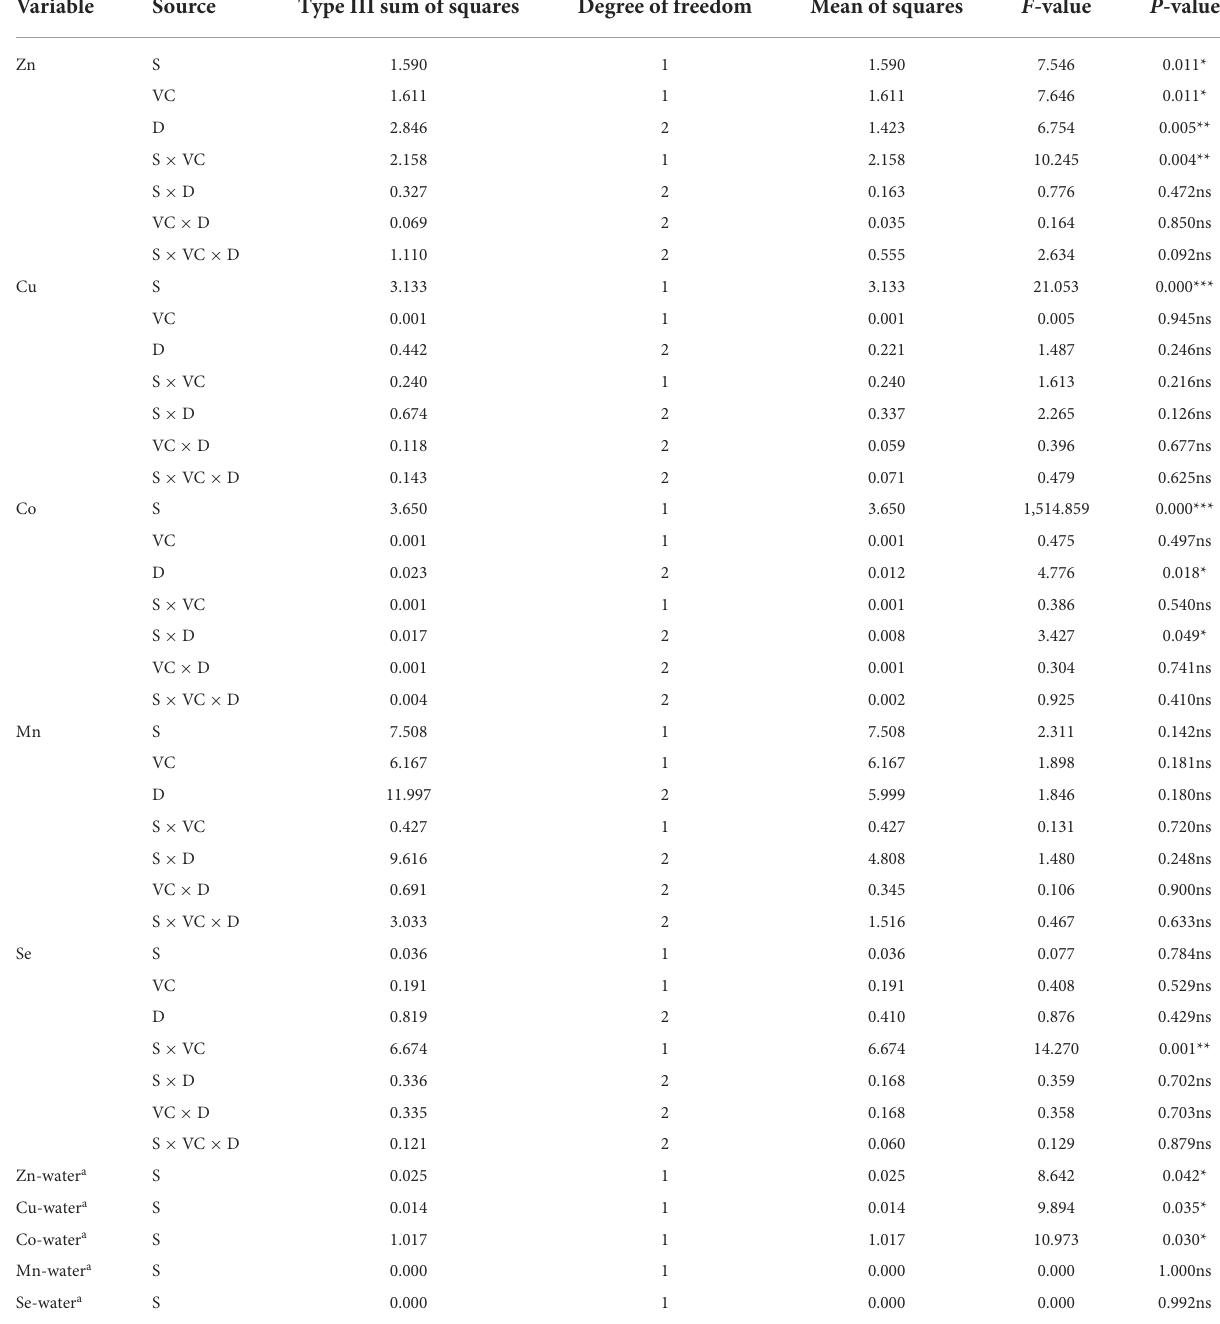
TABLE 1 Analysis of variance (ANOVA) for metal concentrations in coastal soil and water samples of Shadegan wetland. Variable Source Type III sum of squares Degree of freedom Mean of squares F -value P -value